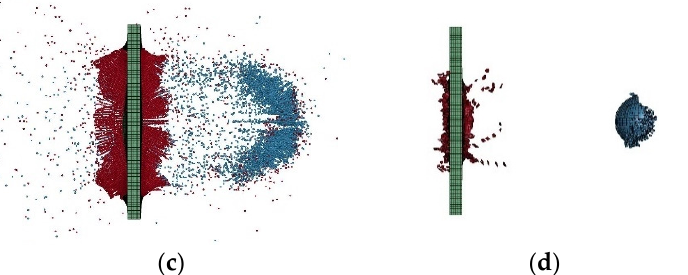
Figure 21. Comparison of simulation effects of debris clouds. ( a ) Debris cloud of the smooth particle hydrodynamics method; ( b ) debris cloud of the finite element method-smooth particle hydrodynamics adaptive coupling method; ( c ) debris cloud of the finite element method-smoothed particle Galerkin fixed coupling method; ( d ) debris cloud of the node separation method. In terms of accuracy, the SPH and FEM-SPH adaptive coupling methods are compared with the test results under different mesh sizes, as shown in Figure 22.